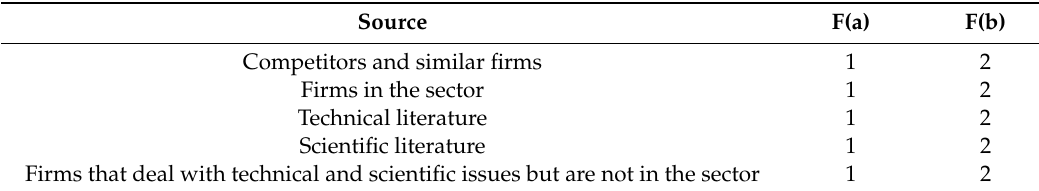
Figure 4. Calculation of the innovation factor of the project. Table 3. Evaluation table.